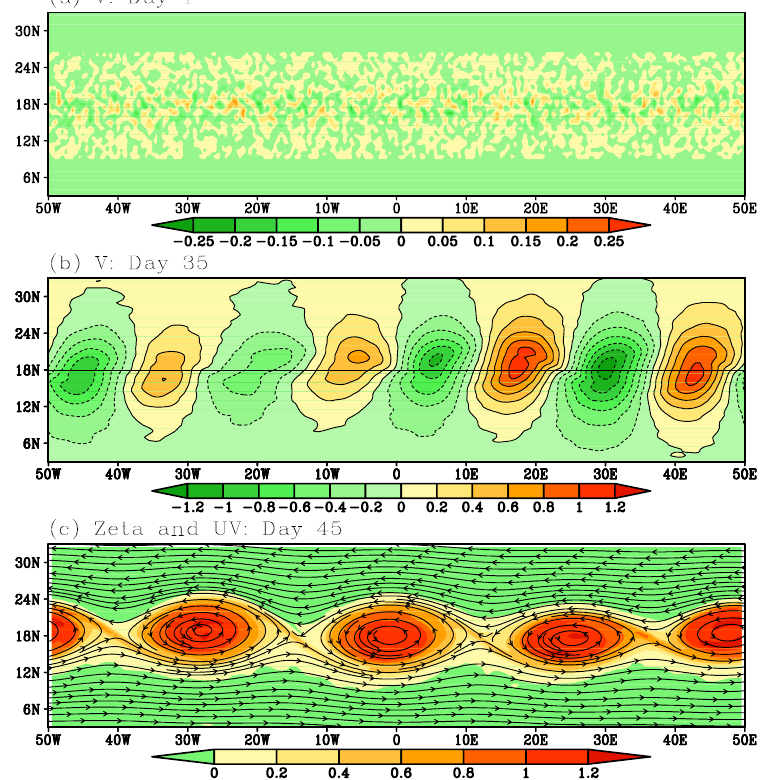
Fig. 2. Meridional wind disturbance (unit: ms − 1 ) at sea surface from the idealized dry model simulation (see text for details) at (a) Day 1 and (b) Day 35, and (c) relative vorticity (unit: 10 − 5 s − 1 ) and streamlines at Day 45 in the co-moving frame of reference that moves at the zonal phase speed of the waves ( − 5ms − 1 ).